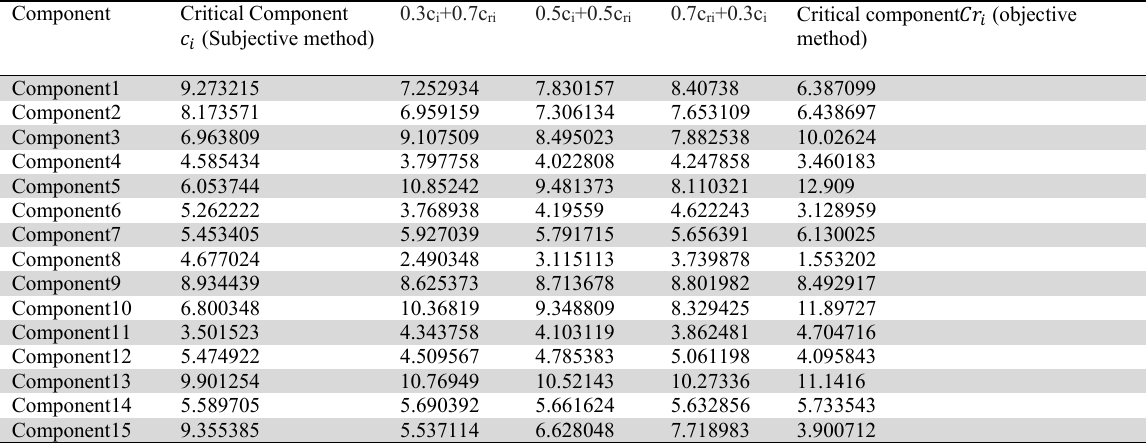
Identification of critical component using combined approach